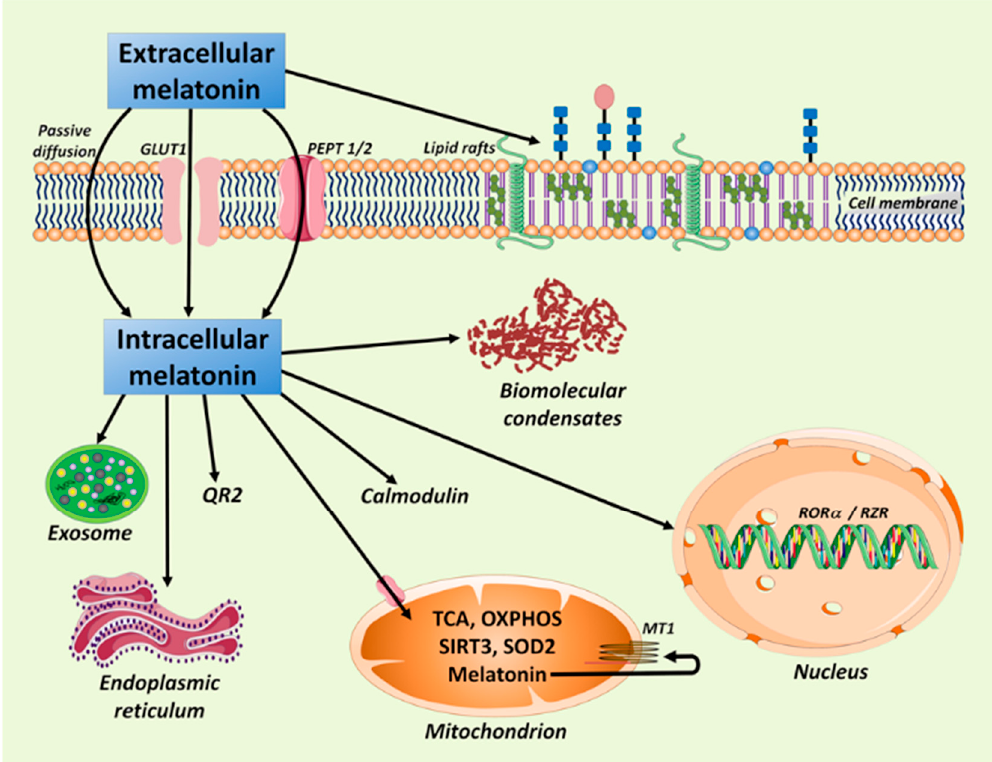
Figure 1. This figure summarizes the intracellular actions of melatonin. Melatonin enters cells by at least three routes, i.e., passive diffusion, GLUT1 glucose transporter (during which it reportedly competes with glucose), and via the PEPT1/2 oligopeptide transporters. Melatonin also influences lipid rafts—specialized microdomains in the cell membrane, which appear to be involved in cancer signaling. Intracellular cytosolic melatonin, either taken up from the blood or synthesized in the resident mitochondria, has multiple actions, including impacting exosome formation and cargo packaging, reducing endoplasmic reticulum (ER) stress, and binding calmodulin and quinone reductase 2 (QR2); the latter is generally referred to as MT3 melatonin receptor. In the mitochondrial matrix, melatonin influences the tricarboxylic acid cycle (TCA), mitochondrial oxidative phosphorylation (miOXPHOS), sirtuin 3 (SIRT3), superoxide dismutase 2 (SOD2), etc. Melatonin, produced in the mitochondria (as well as that imported from outside the cell) may also interact with the MT1 receptor on the mitochondrial membrane. Melatonin also enters the nucleus to bind the ROR α /RZR nuclear receptors and perhaps influences the makeup of biomolecular condensates, cytosolic conglomerates of biomolecules that are involved in a variety of cell processes including cancer. Biomolecular condensates, such as lipid droplets, are not bound by a membrane.